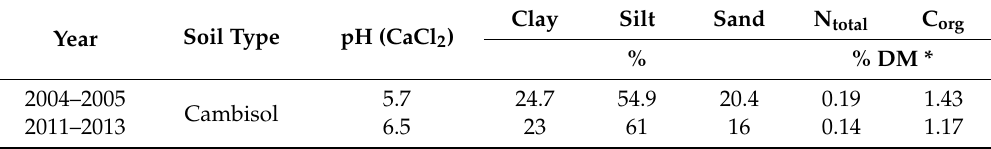
Table 1. Soil characteristics of the experimental site from 2004 to 2005 and 2011 to 2013. Clay Silt Year Soil Type pH (CaCl 2 )